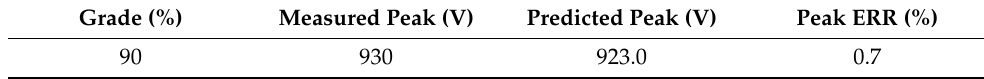
Figure 5. The prediction of GDT’s response at the current injection level of 90%. Table 4. The peak ERR between measurement and prediction of 1 MHz and 3 MHz.